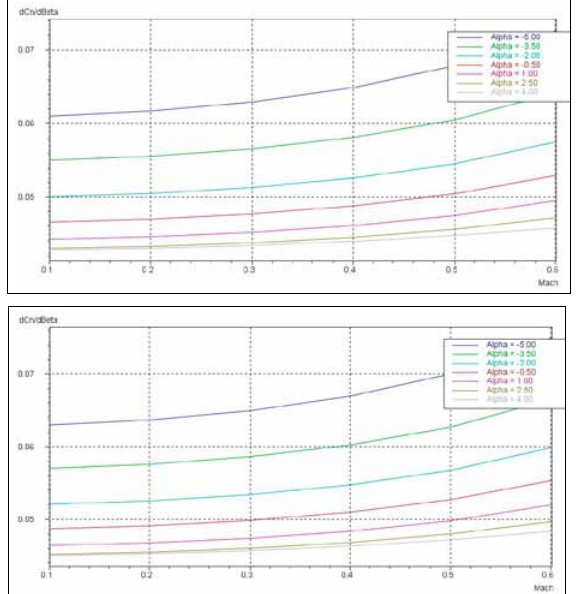
Fig. 9. The flight parameters in trim: angle of attack, elevator deflection and thrust for the MAS configuration No.